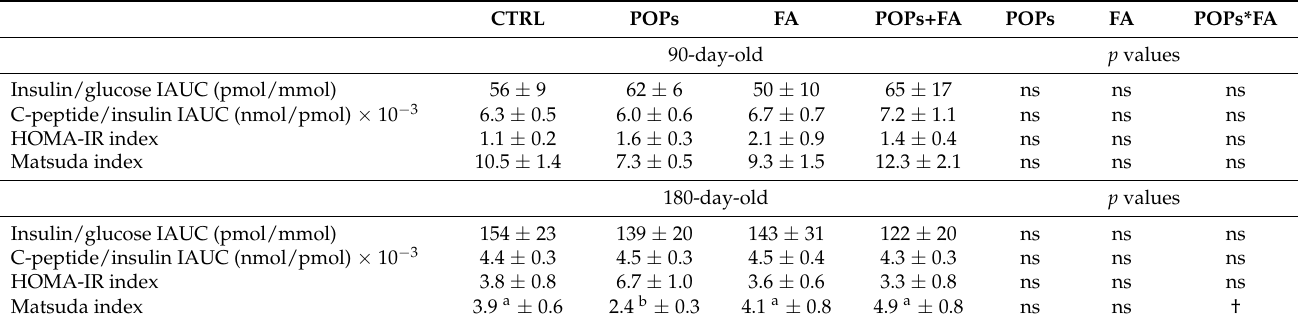
Table 6. Estimates of insulin sensitivity, insulin clearance (hepatic extraction) and β -cell function in F3 male rats. CTRL POPs FA POPs+FA